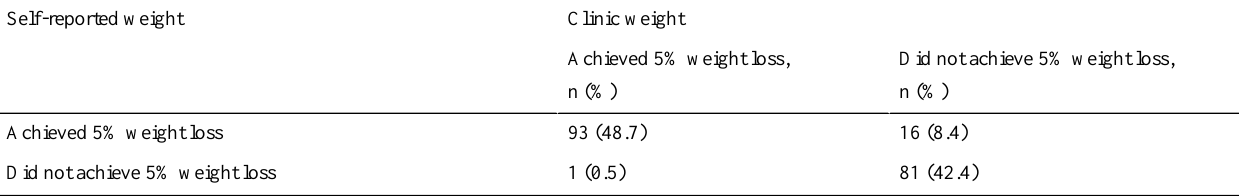
Table 3. Weight loss goal attainment at 24 months based on final weight from clinic and self-reported weight